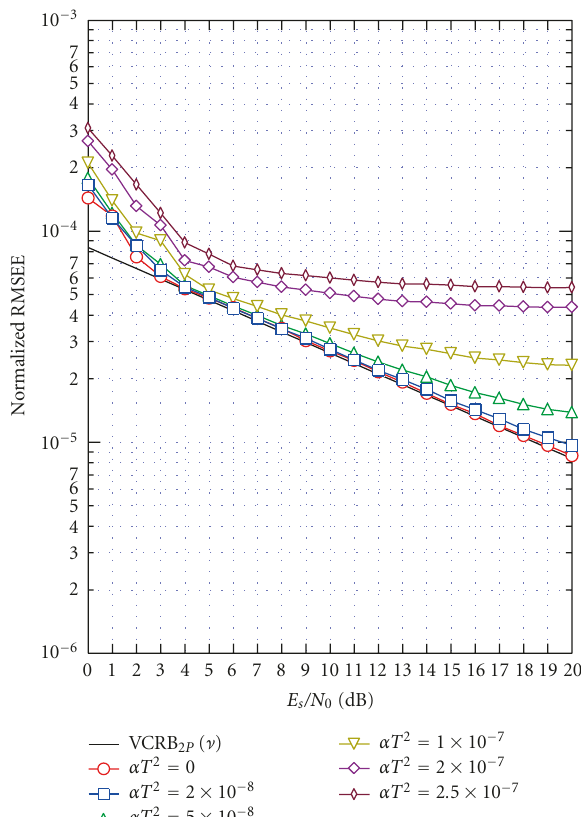
Figure 4: Sensitivity of FEPE estimator to di ff erent values of the Doppler-rate αT 2 . Preamble + postamble DA ML phase estimation, N = 44, M = 385, vT = 1 . 0 × 10 − 3 .